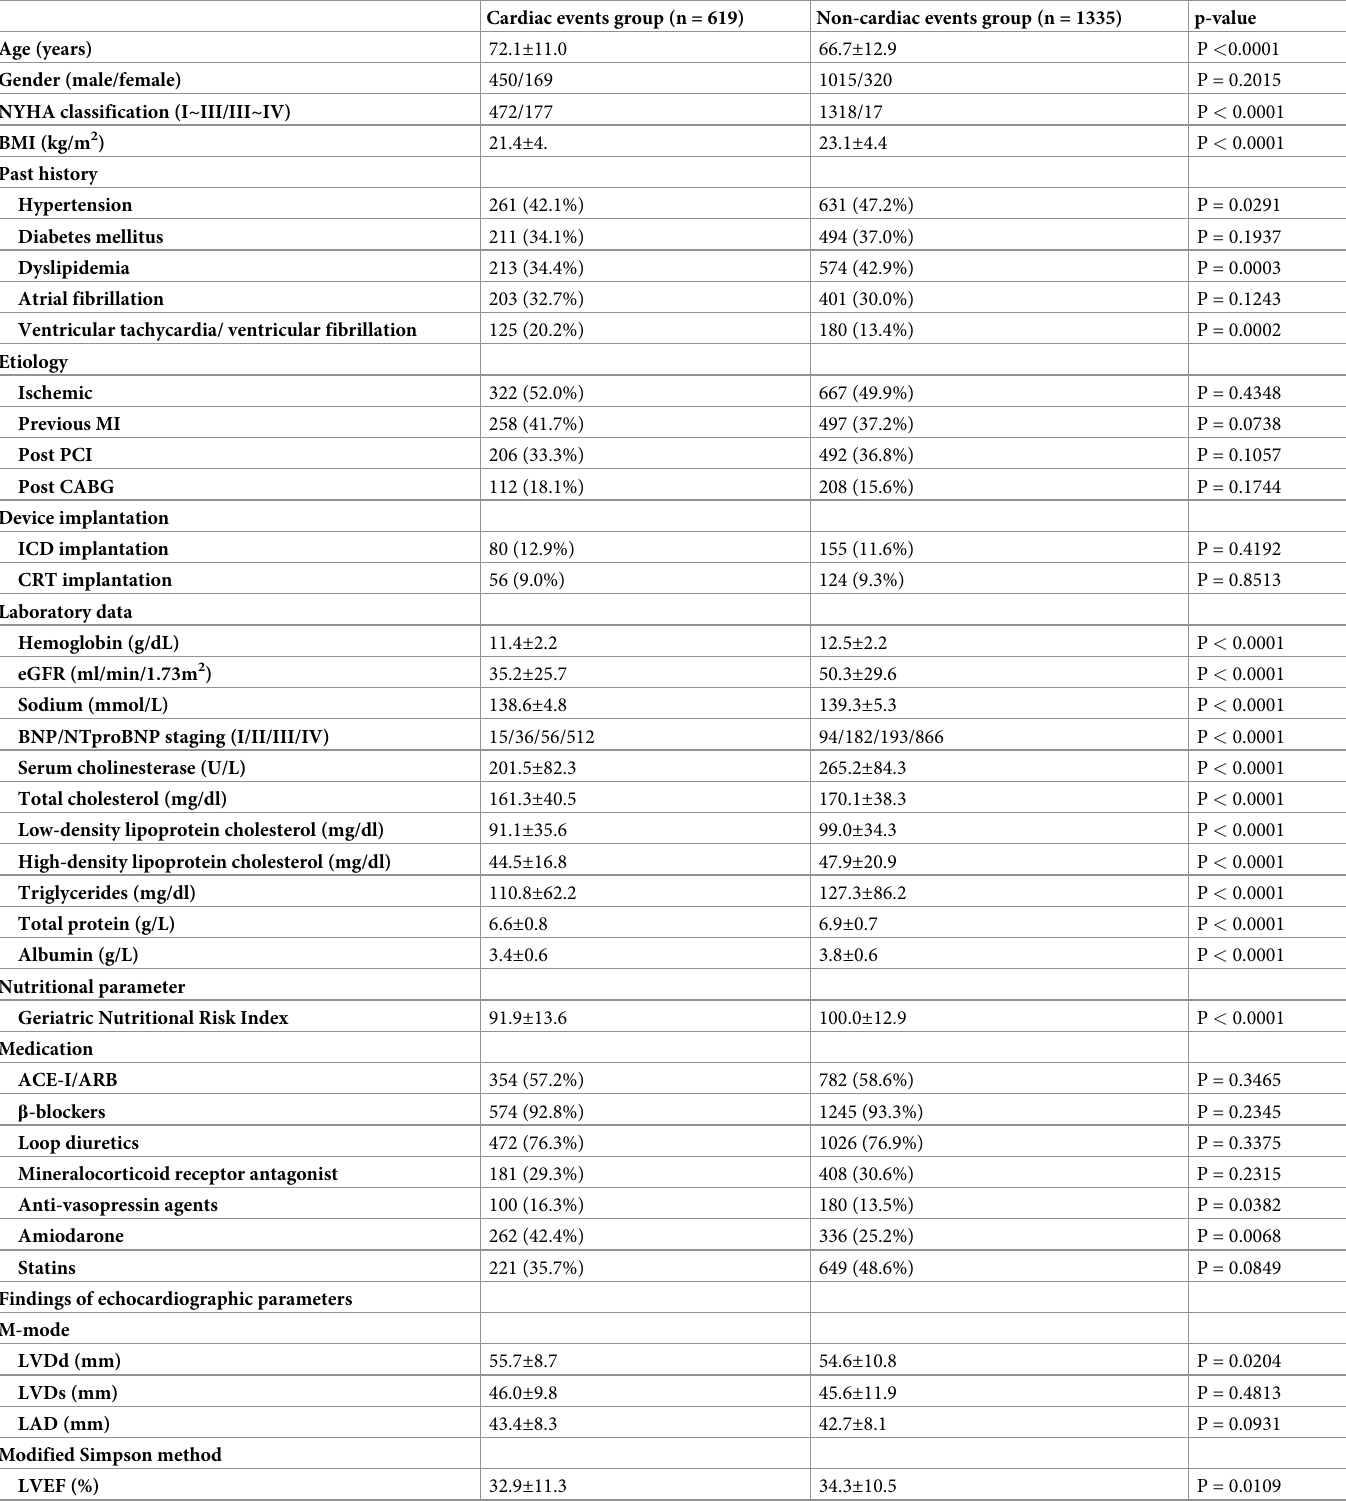
Table 1. Comparison of clinical data and two-dimensional echocardiographic parameters in the groups with and without cardiac